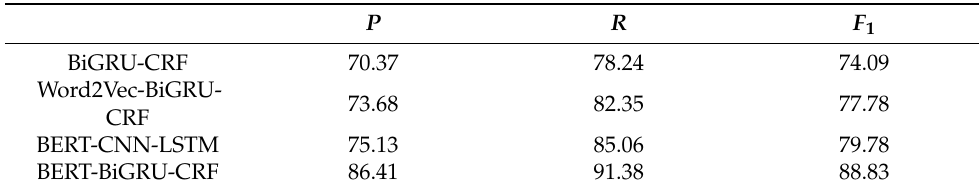
Figure 6. The P , R , and F 1 values during the training process. ( a ) P values; ( b ) R values; ( c ) F 1 values. The results of the comparison at epoch 50 are summarized in Table 6. It can be seen that the P , R , and F 1 values of the BERT-BiGRU-CRF model are 86.41%, 91.38%, and 88.83%, respectively, at epoch 50, which are all higher than other models. Table 6. Results of the entity extraction by different models (%).